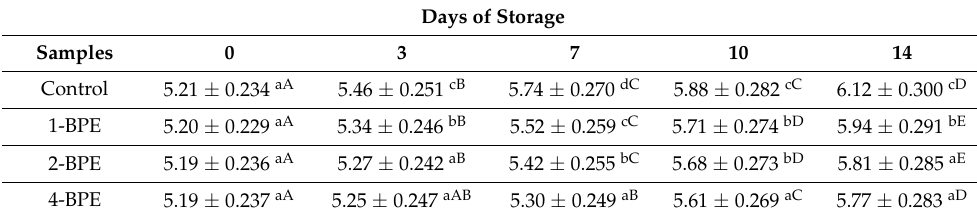
Table 7. pH values of raw minced beef stored at 4 ◦ C for 14